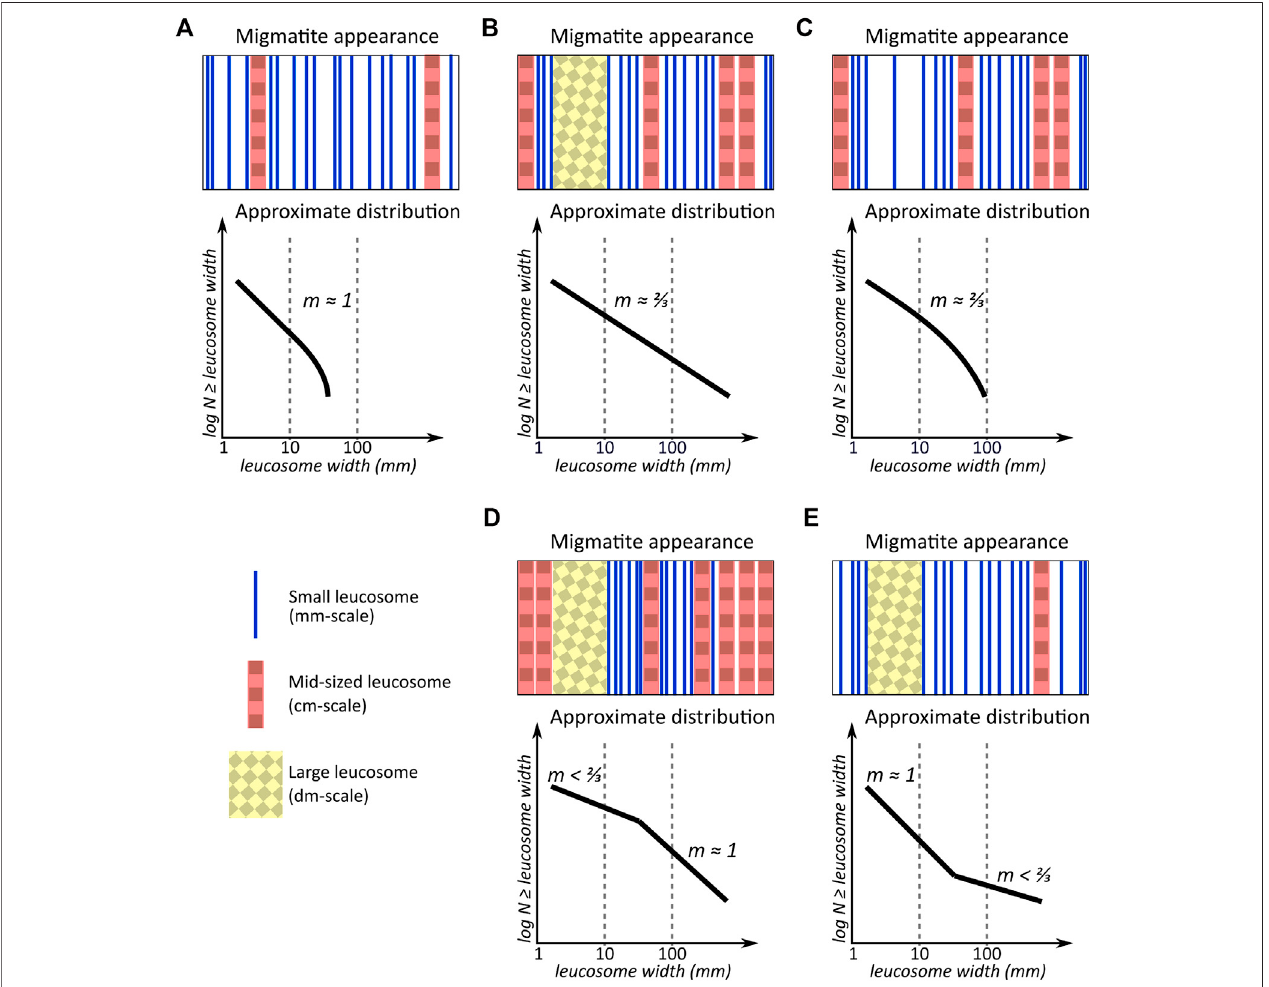
FIGURE 6 | Schematic illustrations of leucosome distribution on hypothetical outcrops (top) and in corresponding cumulative log-log distribution diagrams (bottom). For simplicity, all leucosomes of mm-scale are drawn as small, all of cm-scale as mid-sized, and all of dm-scale as large. To make the distribution diagrams comparable,thenumberofleucosomesineachexampleis20.Thespacingbetweenleucosomesinthehypotheticaloutcroppicturesisnottoscalewiththeleucosome widths. (A) In a system with little melt, most of the melt is situated in small, separated melt conduits and no large leucosomes have formed. Solidi fi cation of such system leads to a power-law distribution with high exponent m . (B) Production of more melt instead of solidi fi cation in example (A) would lead to the formation of larger melt-bearing veins through merging. Leucosomes solidi fi ed at this stage would show a smaller value of the exponent m than in (A) . (C) If the large leucosome in (B) had escaped the system before solidi fi cation but the other melt-bearing veins remained in the host, the resulting leucosome width distribution would be truncated but have similar exponent as (B) . This differs from (A) in containing more mid-sized leucosomes. (D) Over-abundance of mid-sized leucosomes in comparison to both small and large leucosomes manifests as a positive kink in the width distribution diagram. (E) Similarly, a negative kink emerges in the distribution diagram when a migmatite is depleted of mid-sized